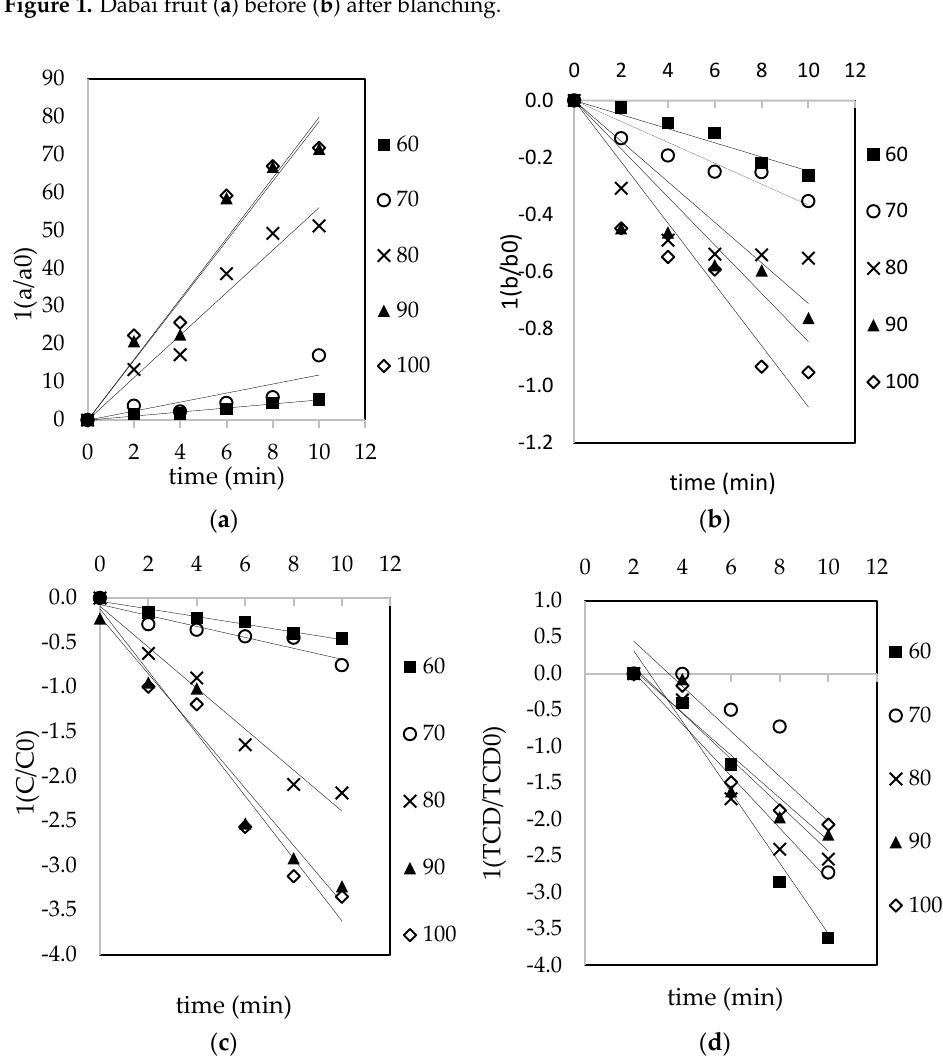
Figure 2. Zero-order kinetic model of the effect of blanching (60, 70, 80, 90 and 100 ° C) on the color parameters of Dabai fruit: ( a ) a *, ( b ) b *,( c ) chroma and ( d ) TDC .